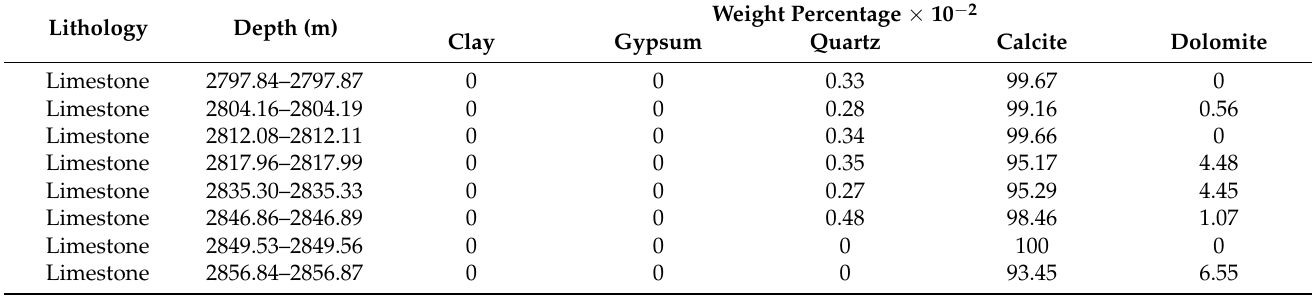
Table 1. The mineral composition of limestone from the Mi4 member.